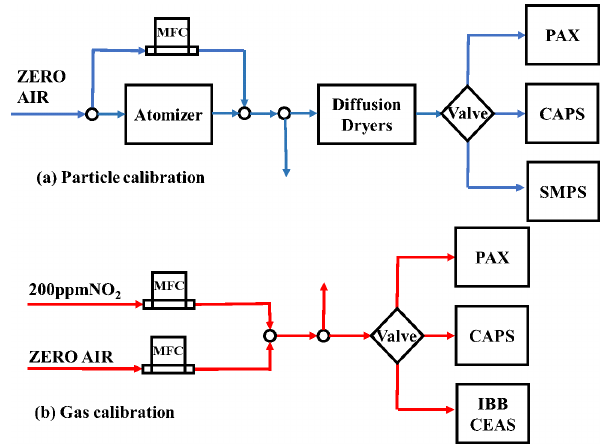
Figure 1. Experimental schematics: (a) particle calibration; (b) gas